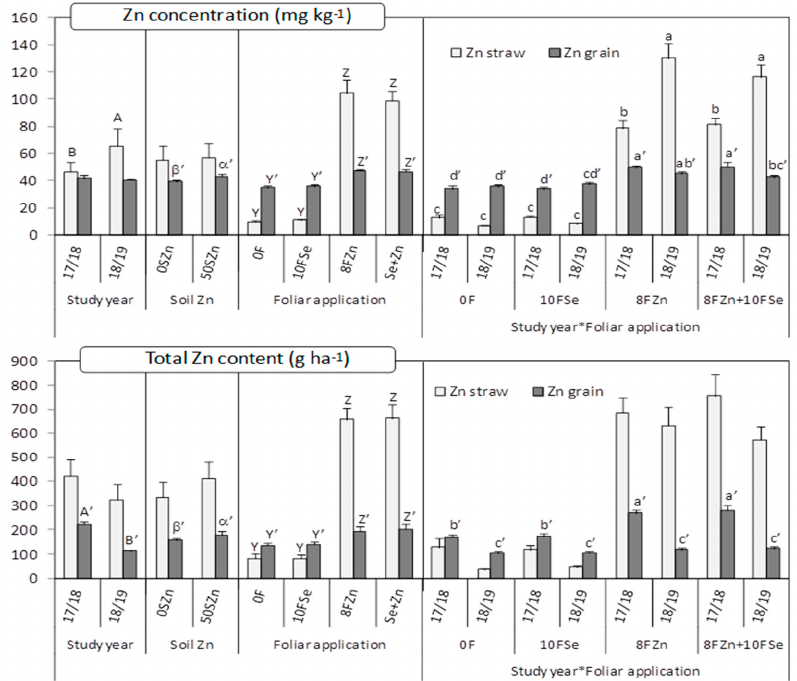
Figure 2. Concentration of Zn and total Zn content in the straw and grain as affected by the main effects ‘Study year (Y)’, ‘Soil Zn application (S)’, ‘Foliar application (F)’, and by the interaction ‘Y*F’. Charts indicate means (for straw n = 3; for grain n = 4) and error bars indicate standard error. Within each factor and plant part, different letters mean significant differences between means according to LSD test ( p ≤ 0.05). To make the differences clearer, a different set of letters was assigned to each factor and plant part (lowercase letters for ‘Y*F’, Greek letters for ‘S’, uppercase letters [A, B] for ‘Y’ and uppercase letters [Z, Y] for ‘F’). Letters follow by apostrophe (‘) for grain. Regarding Se, its concentration in the straw and the molar ratio Phytate/Se were only affected by the foliar treatment (Table 1). The treatments containing Se, regardless of the Zn application, produced on average almost a 3-fold increase in the Se concentration in comparison with the rest of treatments (Figure 3). The same pattern was observed for the molar ratio phytate/Se (Table 2). The Se content per ha in the straw, besides the foliar application, was also affected by the study year (Table 1), being 44% higher in 2017/2018 than in 2018/2019. Furthermore, the treatments containing Se produced the highest values of total Se content in the straw (Figure 3).